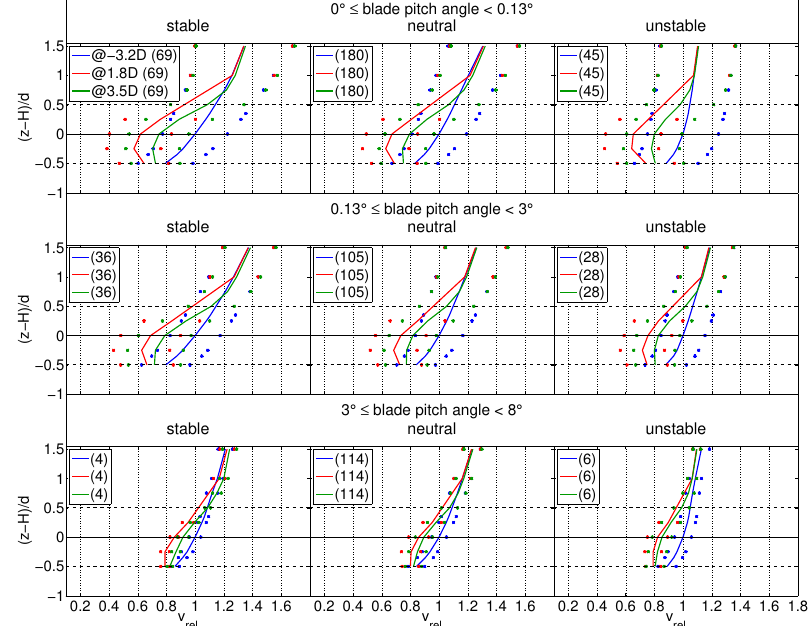
Figure 6. Mean normalized profiles of wind speed v rel filtered for pitch angles between 0 ◦ and 0.13 ◦ (top), 0.13 ◦ and 3 ◦ (center) and 3 ◦ and 8 ◦ (bottom), wind directions between 217 ◦ and 237 ◦ and different stability classes. The individual 10-min average wind speeds of all three LiDAR systems have been normalized by the corresponding 80-m value of the upstream LiDAR wls67 before averaging the number of available profiles indicated in the legend. Dots indicate the standard deviation at each measurement altitude before the normalization.